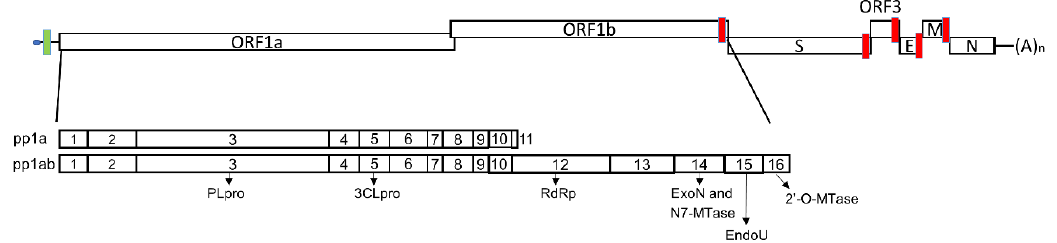
Figure 1. The genomic organization of a PEDV and its structural (S, E, M, and N), non-structural (nsp1 – 16), and accessory (ORF3) proteins. The green and red bars located at the 5 ′ UTR or upstream of each ORF represent the leader TRS and body TRS regions. Abbreviations: a number for pp1a and pp1ab indicate the non-structural proteins 1 – 16. PLpro: Papain-like protease; 3CLpro: chymotryp- sin-like protease; RdRp: RNA-dependent RNA polymerase; ExoN: Exoribonuclease; N7-MTase: